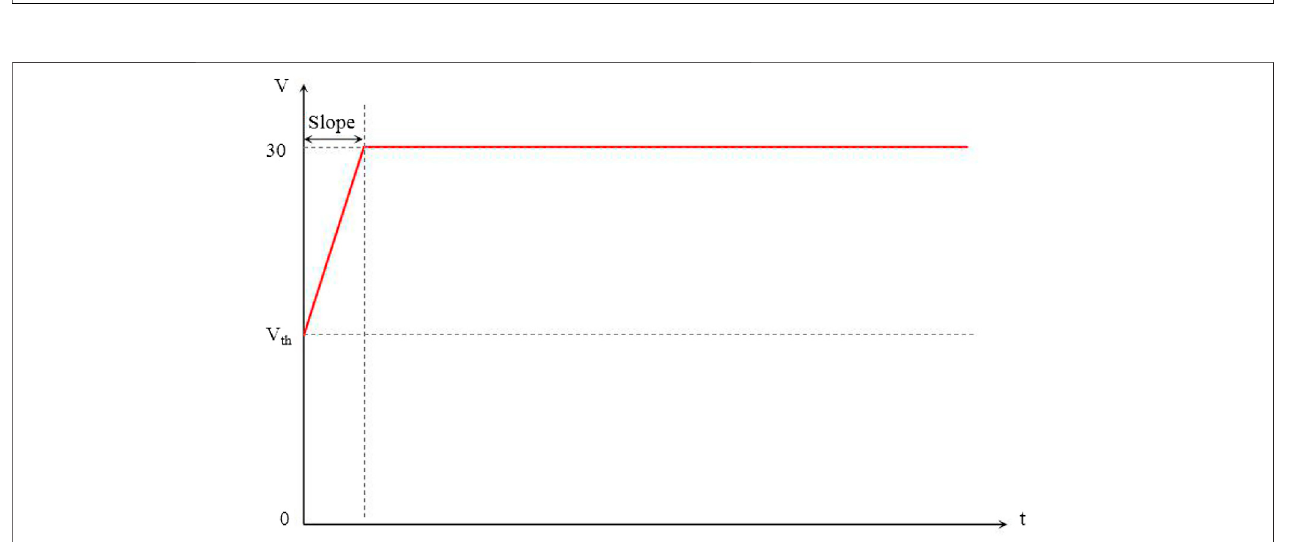
FIGURE 8 | Schematic diagram of a driving waveform with rising gradient design. The rising gradient waveform with slope from V th to 30 V. V th (cid:2) 15 V.